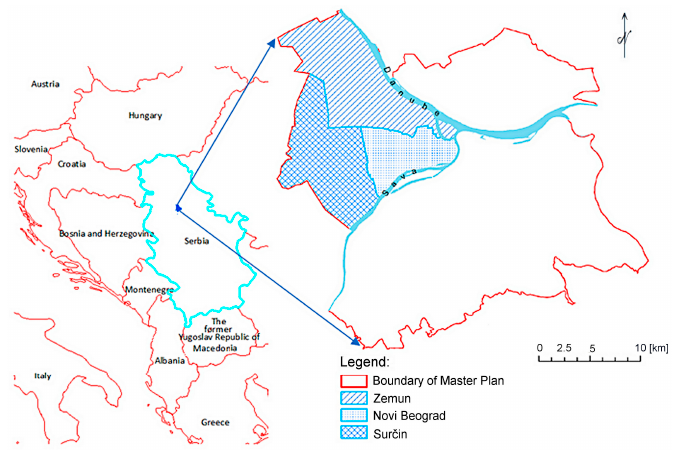
Figure 1. Study area: Municipalities Zemun, New Belgrade, and Sur č in from Belgrade metropolitan area, Republic of Serbia.